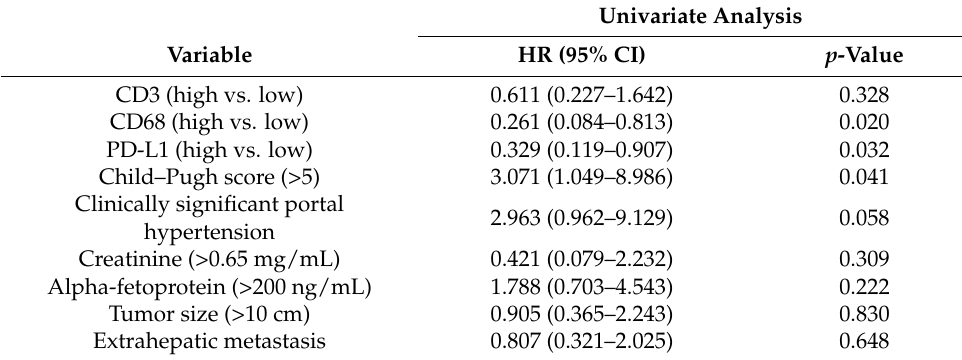
Table 4. Factors associated with progression-free survival analyzed by Cox regression